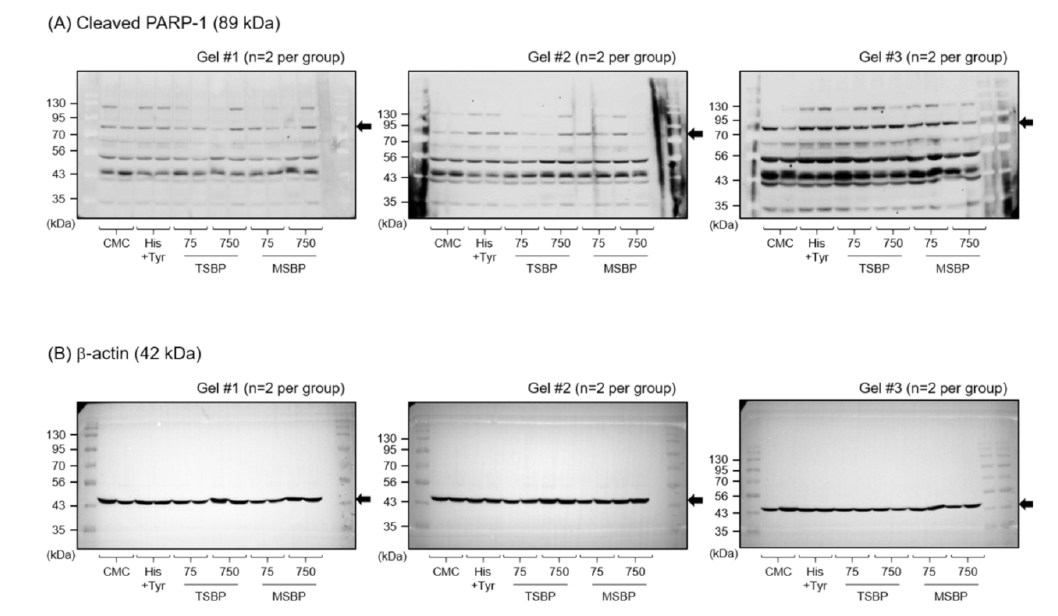
Figure A4. The full-length Western blot images corresponding to Figure 6B. ( A ) PARP-1. ( B ) β -actin for PARP-1. The arrows indicate the appropriate molecular weight of each